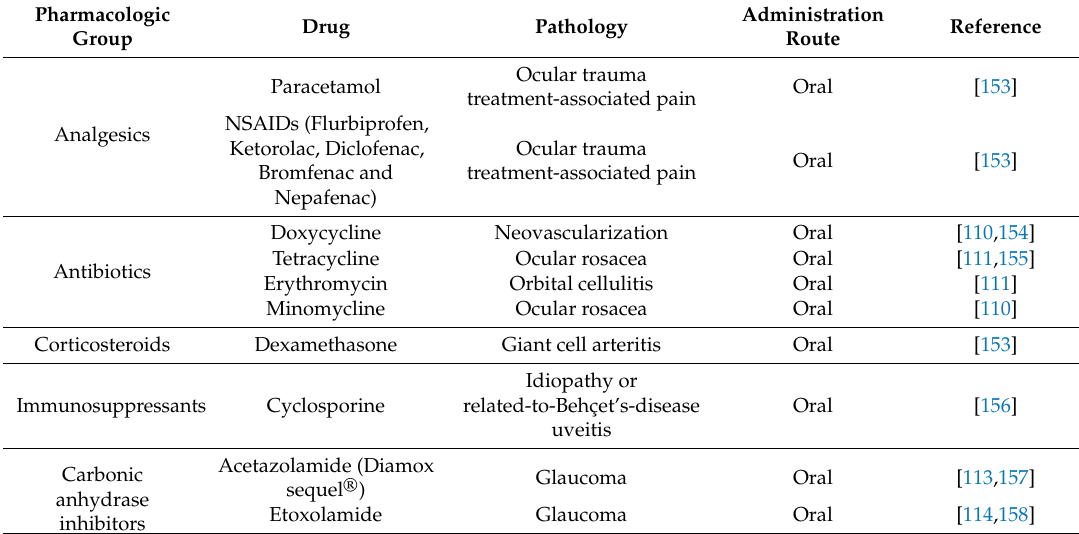
Table 4. Summary of orally administered drugs for the treatment of posterior segment ocular